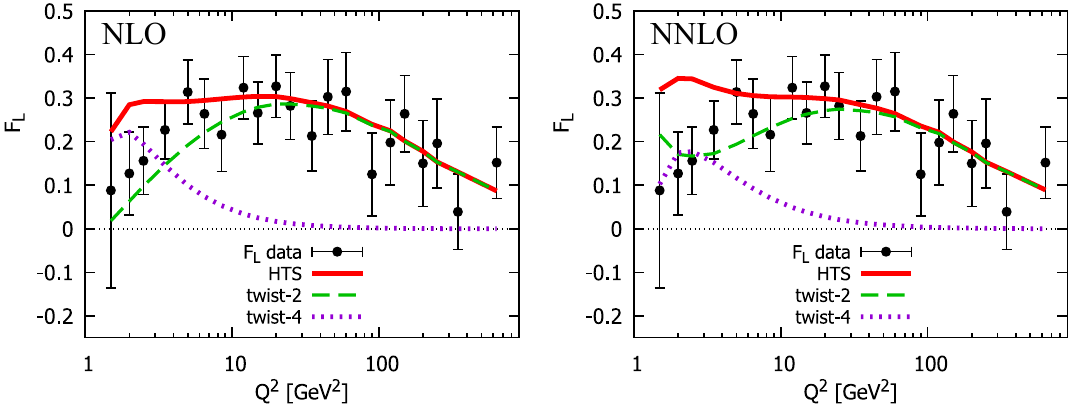
Fig. 6 The predictions for F L from the HTS fit compared to the H1 data [13]. Also shown are twist 2 (dashed green line) and twist 4 (dotted purple line)